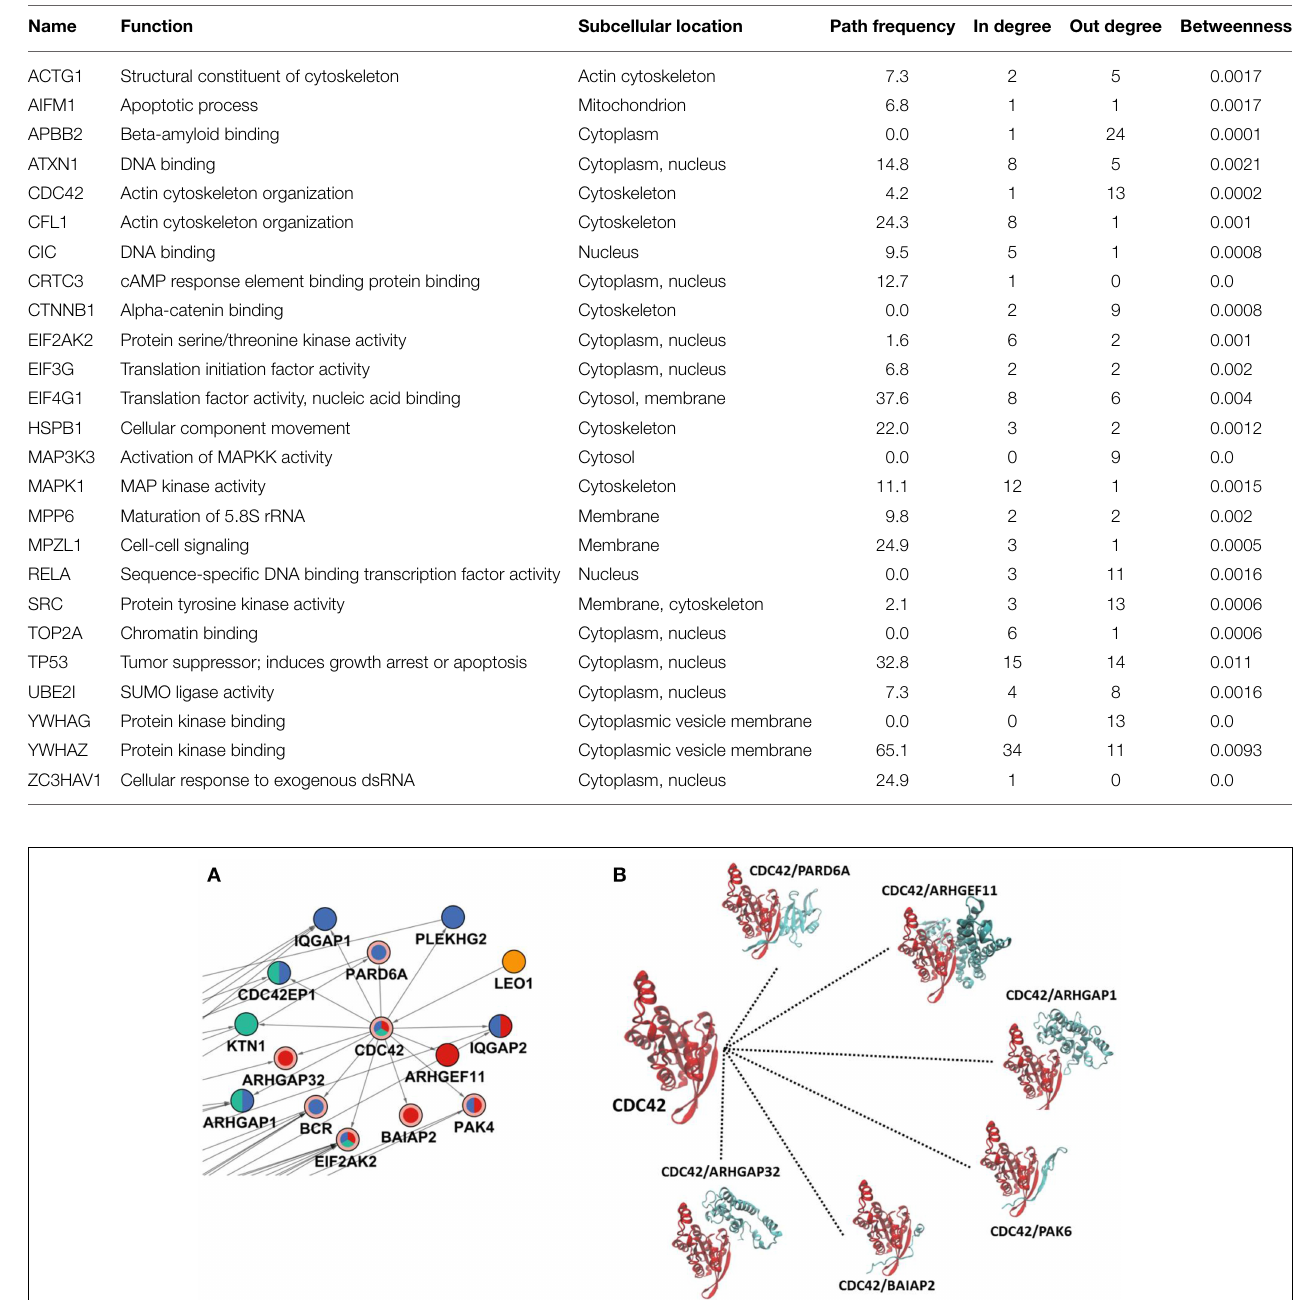
phosphoproteomic hits. (B) Structural details of CDC42 interactions where CDC42 uses the same binding site completely or partially